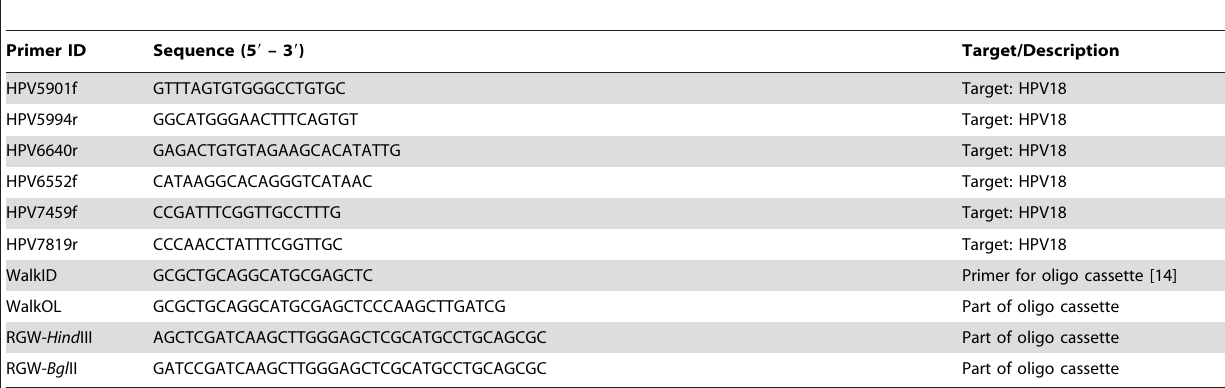
Table 1. PCR Primers and oligos used for target detection, sequencing and genome walking.